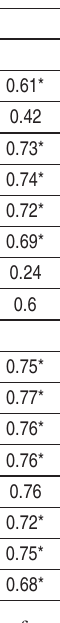
Table 14. Jump frequency criterion - Summarized